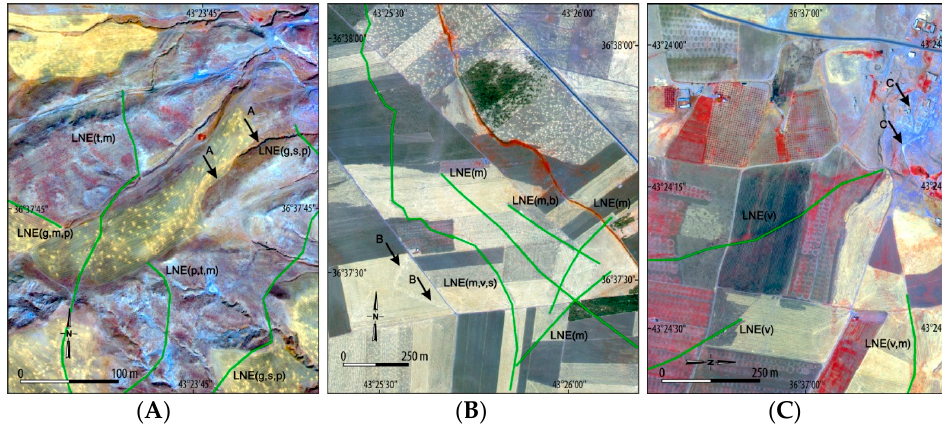
Figure 9. An example of linear features: ( A ) in the upland area—the dominant interpretative feature: geomorphological conditions, transportation routes; ( B ) in lowlands—the dominant feature: local changes in moisture content, dryness; ( C ) in lowlands—the dominant feature: plant indicator. The results after the initial selection (rejection of indicators related to the current LULC (Land Use and Land Cover), Digital elevation model (DEM), for example: A—relationship with the geomorphology of the area; B—traces of agricultural machinery works; C—remains of recent settlement). Background image WV2, FCC 158 IHS (ID10300100388F8C00). WorldView ‐ 2 © 2014 DigitalGlobe,